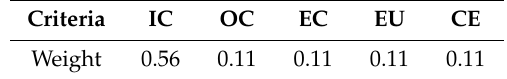
Table 5. Weight of five criteria determined using Analytic Hierarchy Process (AHP).